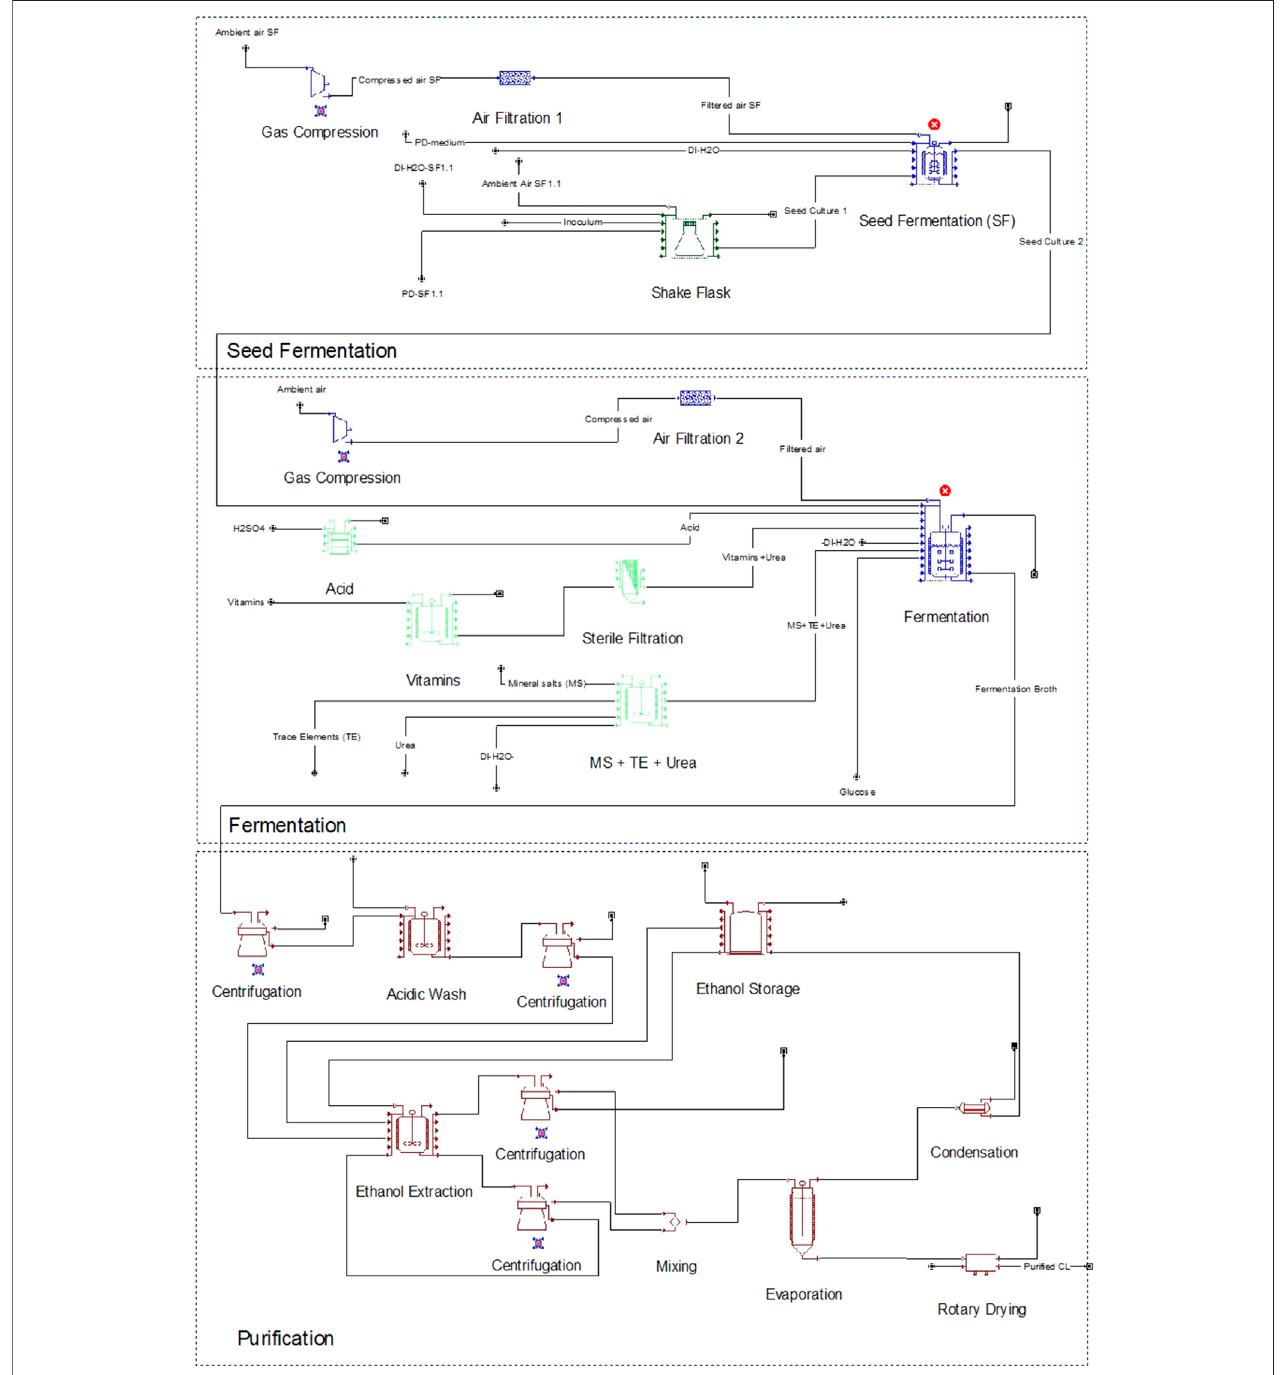
FIGURE 1 | Process fl owsheet for the CL fermentation, including seed fermentation, production culture, and puri fi cation units.